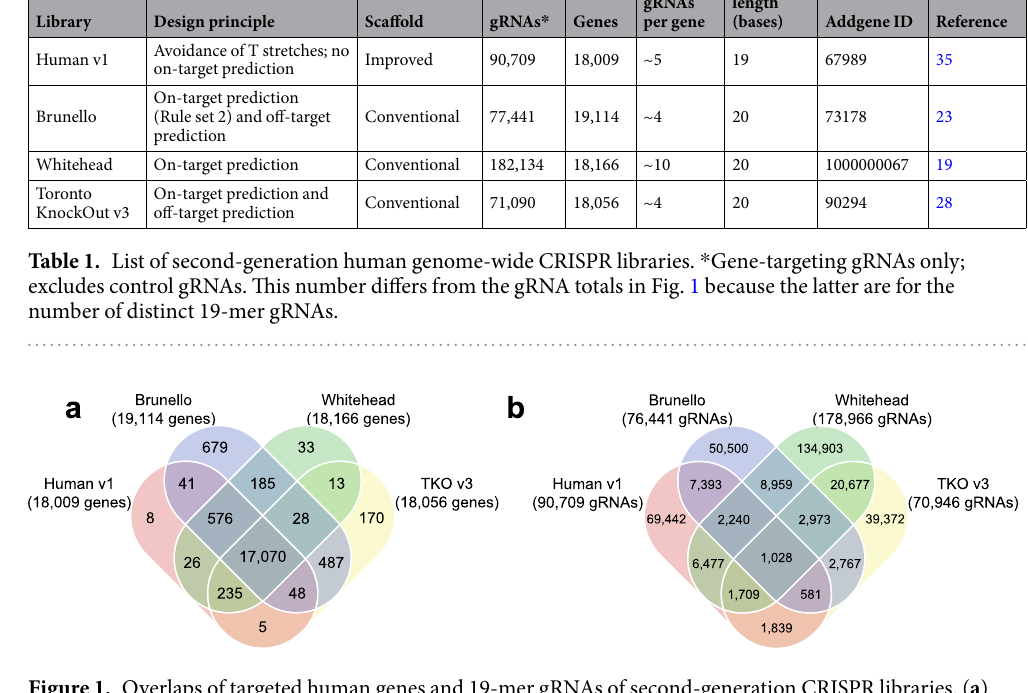
Figure 1. Overlaps of targeted human genes and 19-mer gRNAs of second-generation CRISPR libraries. ( a ) Venn diagram showing overlaps of human genes targeted by four second-generation genome-wide CRISPR libraries. ( b ) Venn diagram showing overlaps of 19-mer gRNAs in four second-generation genome-wide CRISPR libraries. gRNA sequences of the 3 ′ 19-mers were used in order to make the 19-mer gRNAs in the Human v1 library comparable to the 20-mer gRNAs in the other three